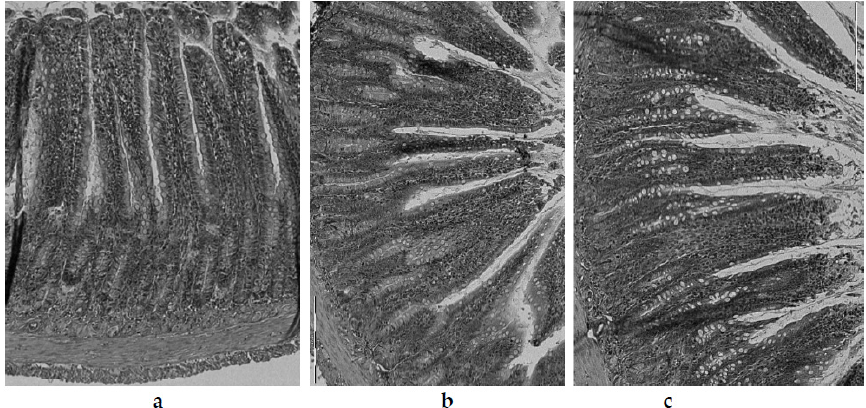
Figure 5. Histological examination of illeum or rats fed with the following diets: control (C) diet ( a ); atherogenic (CH) (containing 1% cholesterol) diet ( b ); and an atherogenic diet, supplemented with lyophilized garlic (CHG) ( c ). Light microscope (×200).